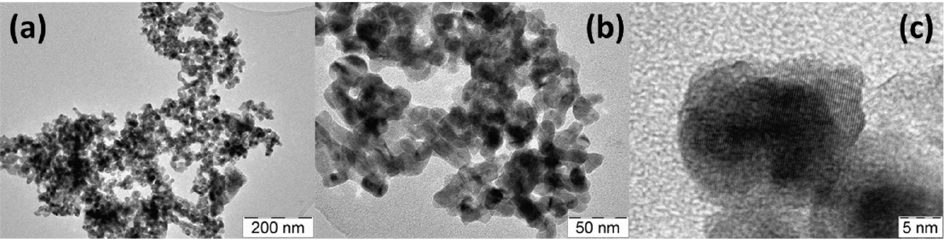
Figure 2. TEM images of the CuO/KB catalyst at three different magnifications. ( a ) 200nm; ( b ) 50 nm; ( c ) 5 nm.